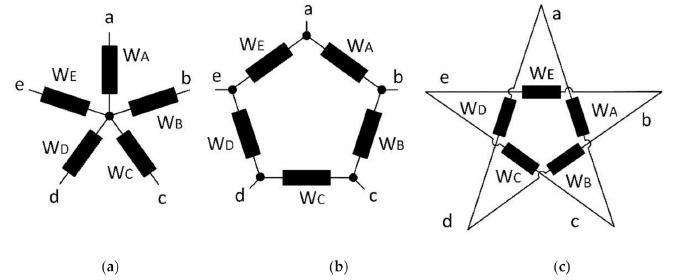
Figure 2. Five-phase motor stator winding connection configuration: ( a ) Star connection; ( b ) Pentagon connection; ( c ) Pentacle